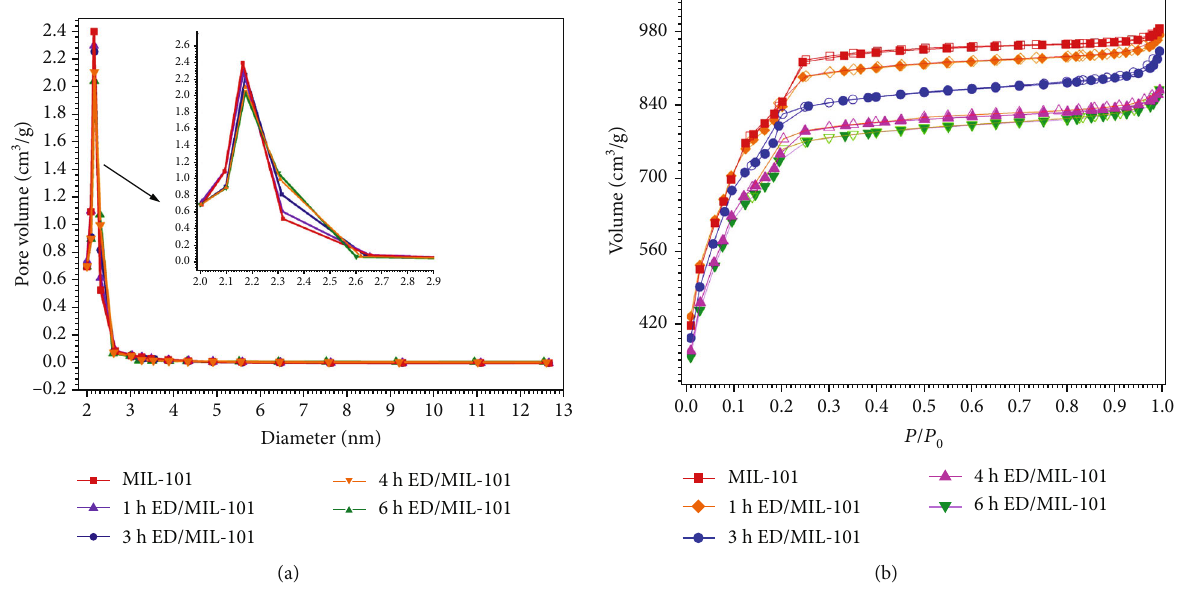
Figure 5: (a) The curves of aperture distribution; (b) nitrogen adsorption-desorption isotherms of etched MIL-101.